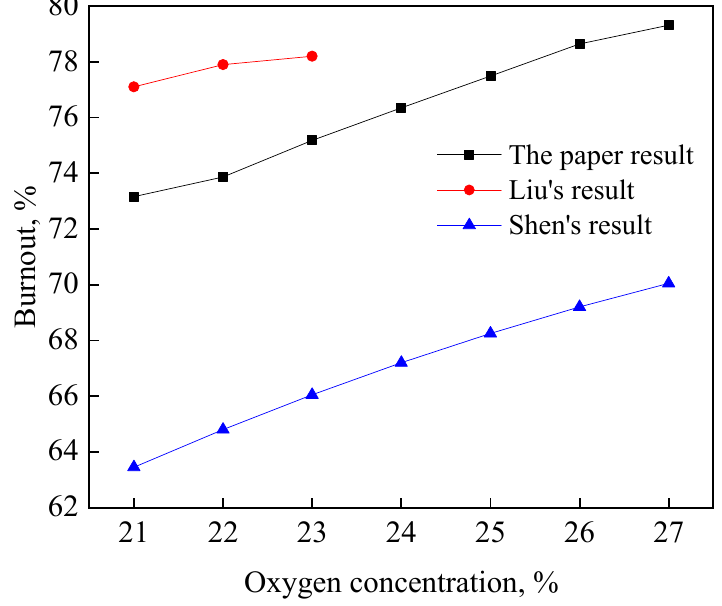
Figure 5. Comparison of simulated results with that of Shen and Liu.